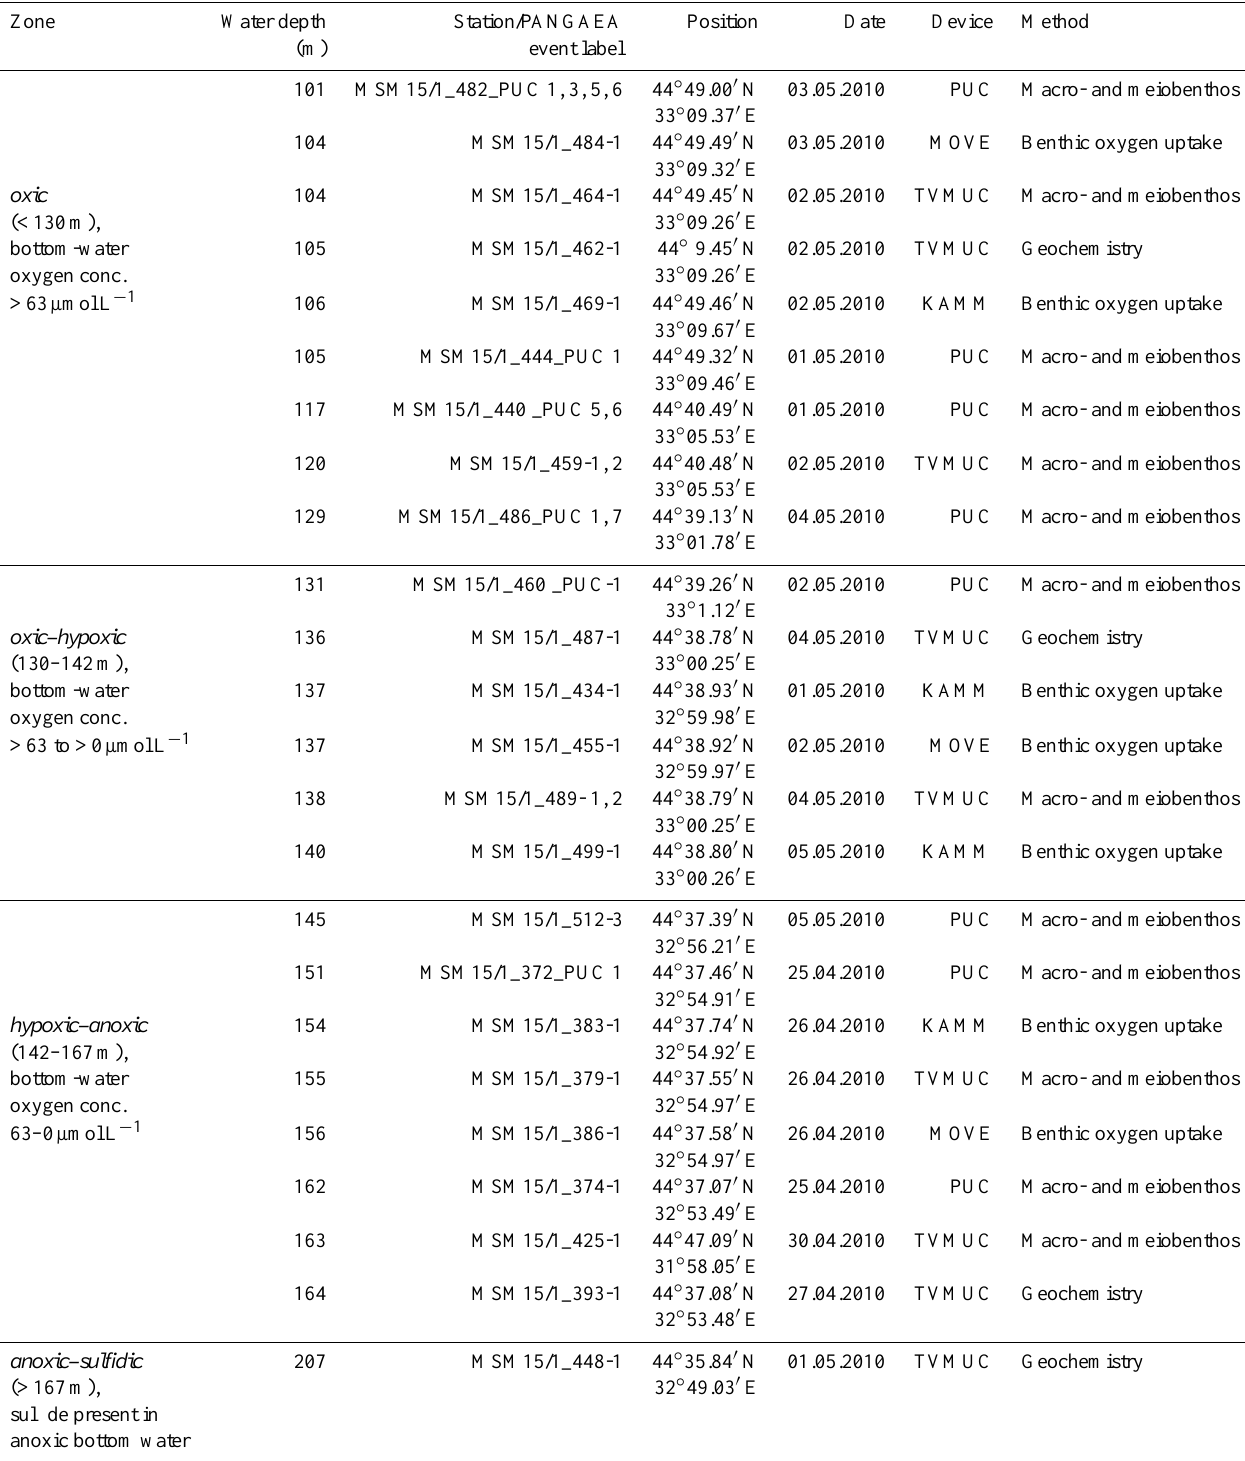
Table 1. Measurements and samples (including PANGAEA event labels) taken in zones with different oxygen regime. PUC represents JAGO pushcores, MOVE represents the benthic crawler move (in situ microsensor measurements and/or benthic chamber deployment), TVMUC represents the video-guided multicorer and KAMM represents the lander (in situ microsensor measurements and/or benthic chamber